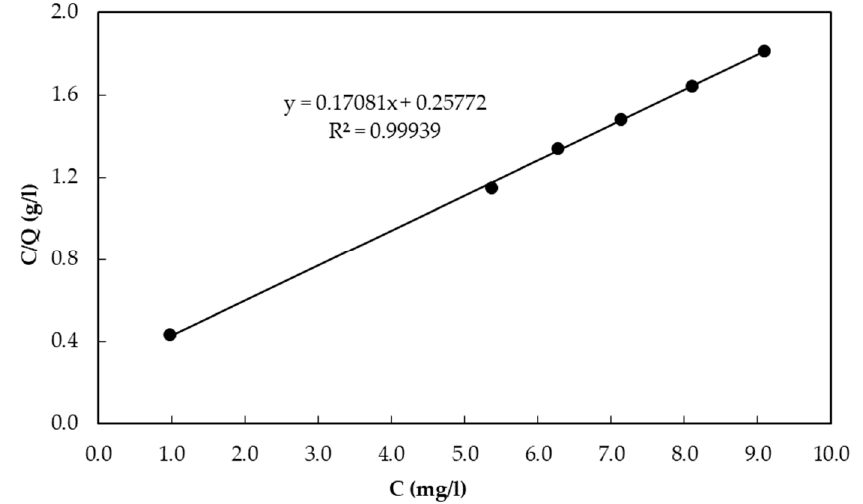
Figure 3. Langmuir isotherm for CBC.